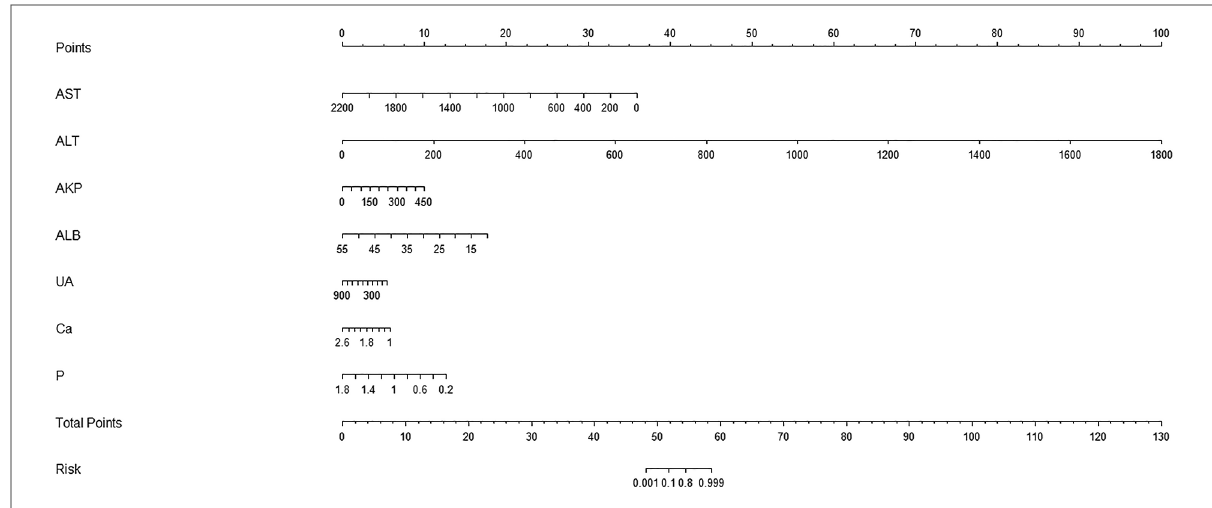
FIGURE 1 A nomogram prediction model of Wilson ’ s disease.